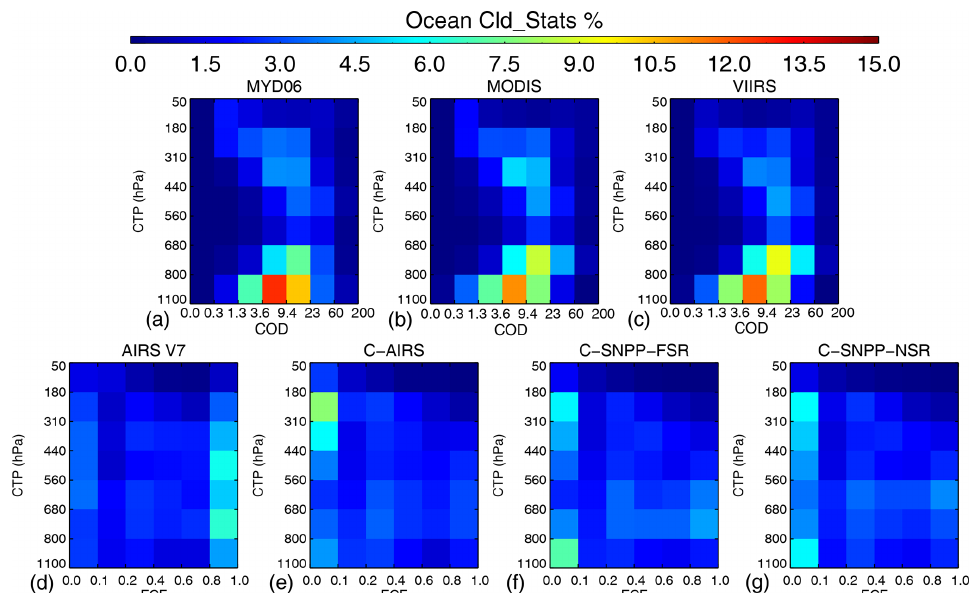
Figure 11. Similar to Fig. 10, except showing results calculated using data over ocean at 60 ◦ N–60 ◦ S. Sounder land fraction < 0 . 1 is used to determine ocean